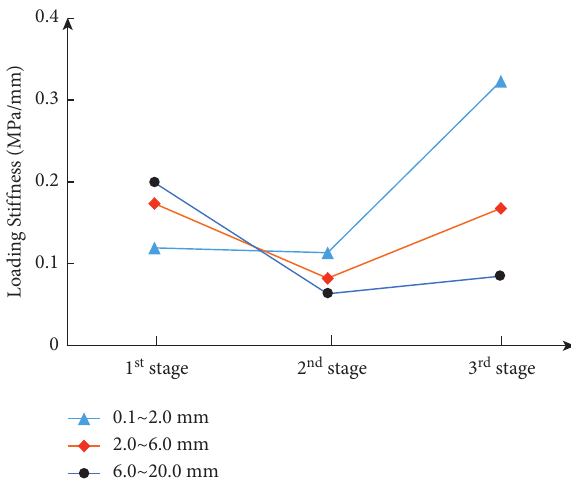
Figure 5: Loading stiffness for different